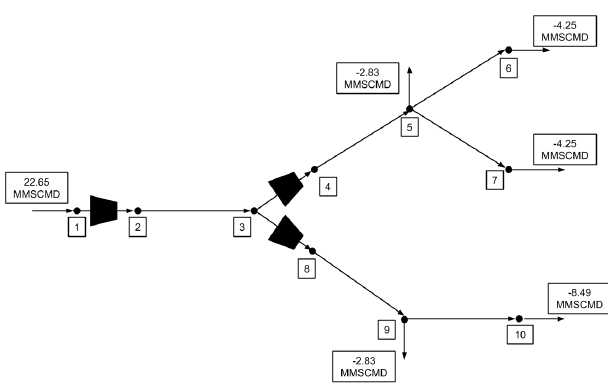
= P L = 2 1 = 2.76 MPa. 10